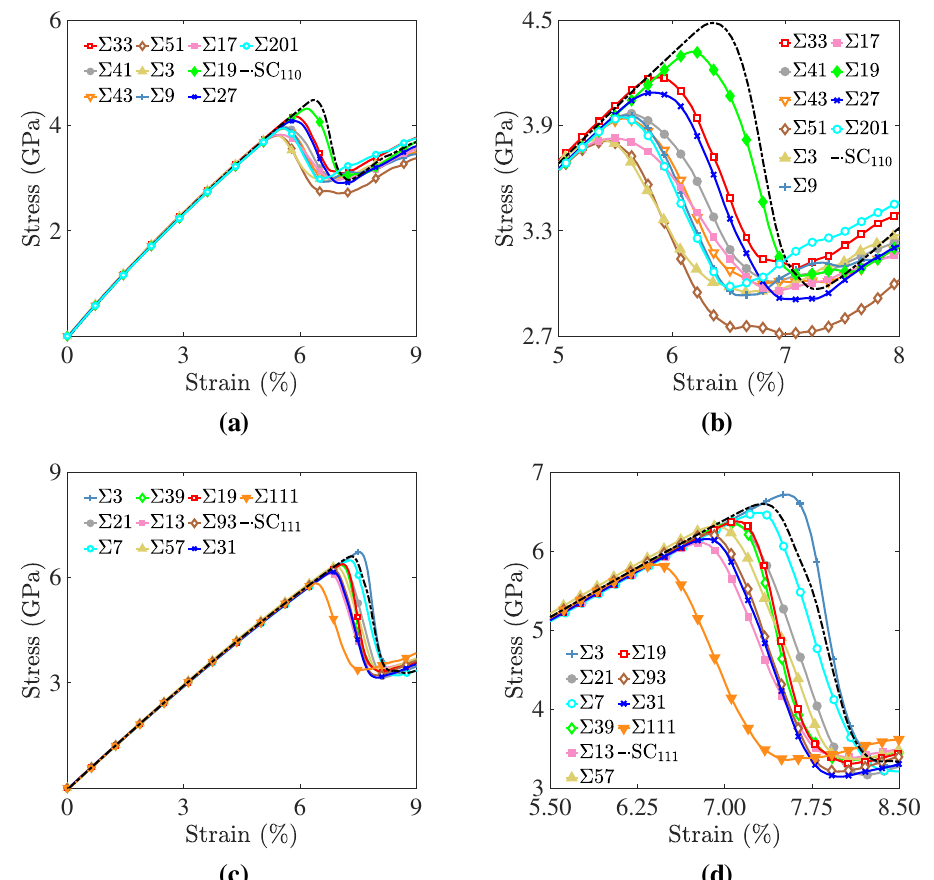
Figure 4. For the Cantor alloy bicrystals: (a,c) tensile stress–strain curves and (b, d) close-up views around the peak points. Curves for bicrystals with (a,b) [110] and (c,d) [111] STGBs are shown. Curves for Cantor alloy single crystals with [110] ( SC 110 ) and [111] ( SC 111 ) loading axis are shown for